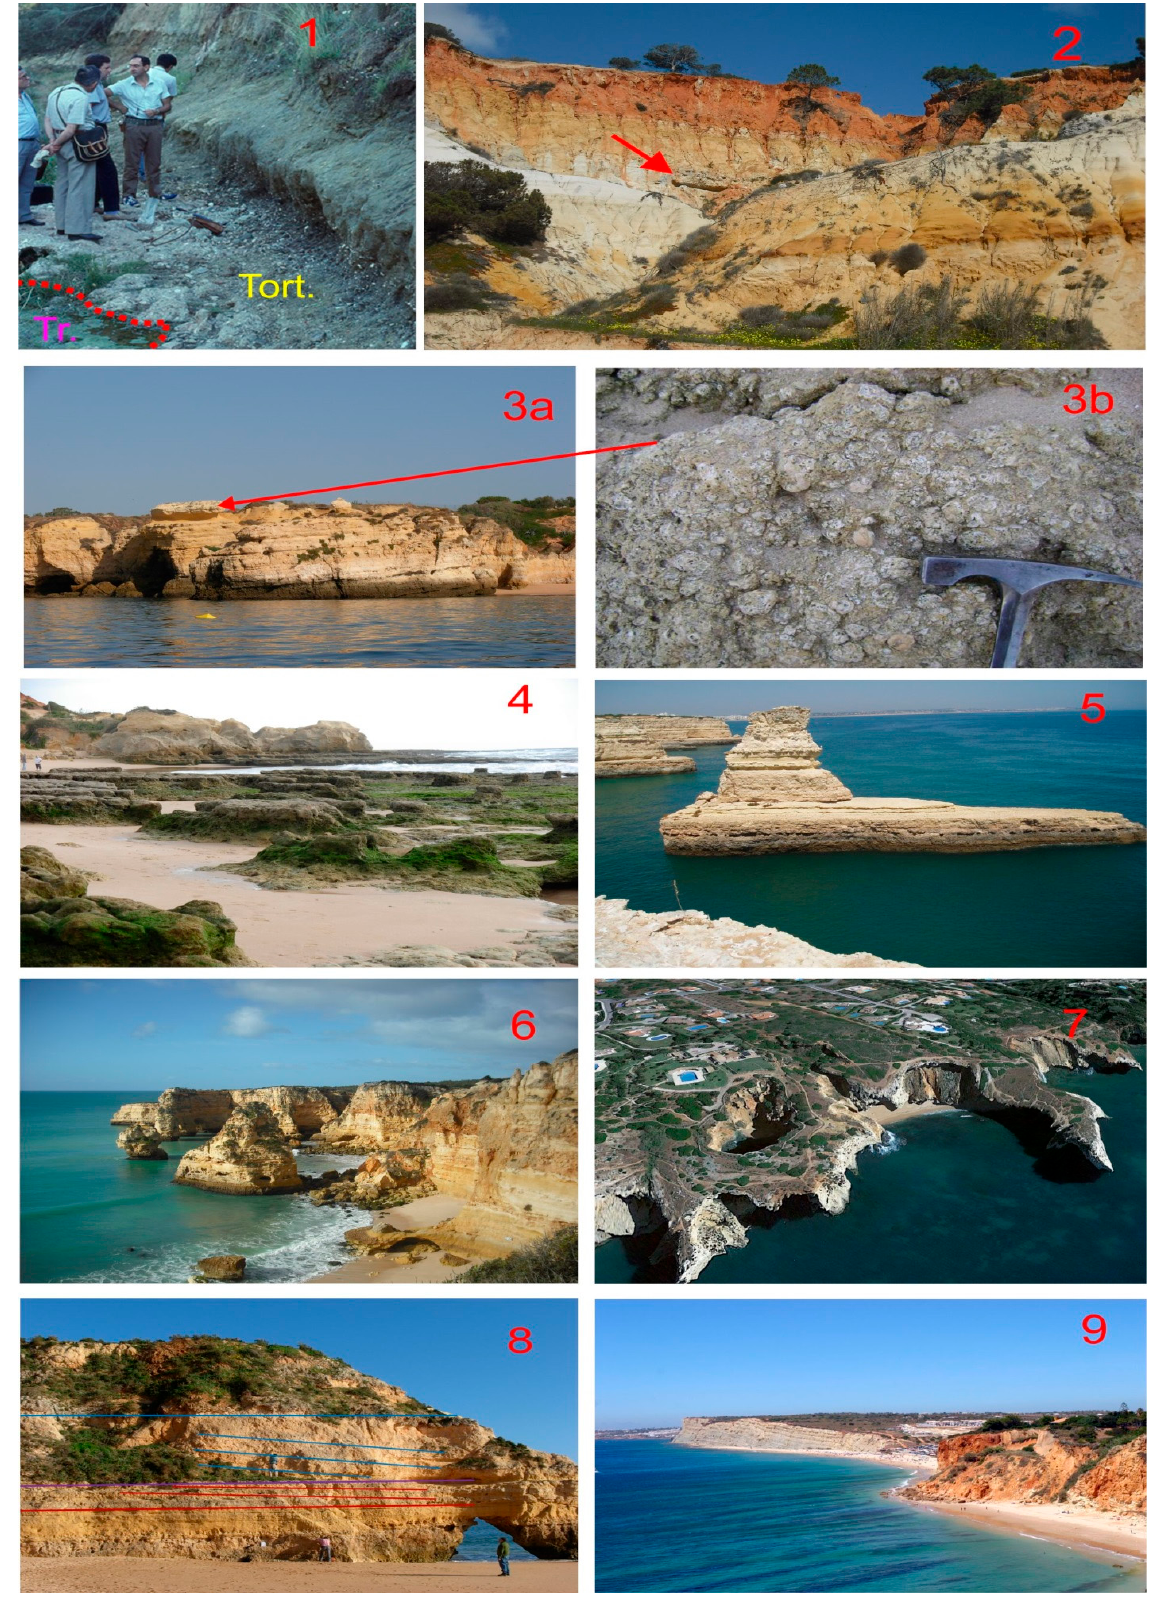
Figure 5. Geosites studied: ( 1 )—Cacela (boundary between Triassic and Tortonian units); ( 2 )—Olhos de Agua; ( 3a )—S. Rafael; and ( 3b )—detail of the rodolites concentration; ( 4 )—Gal é ; ( 5 )—Senhora da Rocha; ( 6 )—Marinha; ( 7 )—Carvoeiro; ( 8 )—Vau-Rocha; ( 9